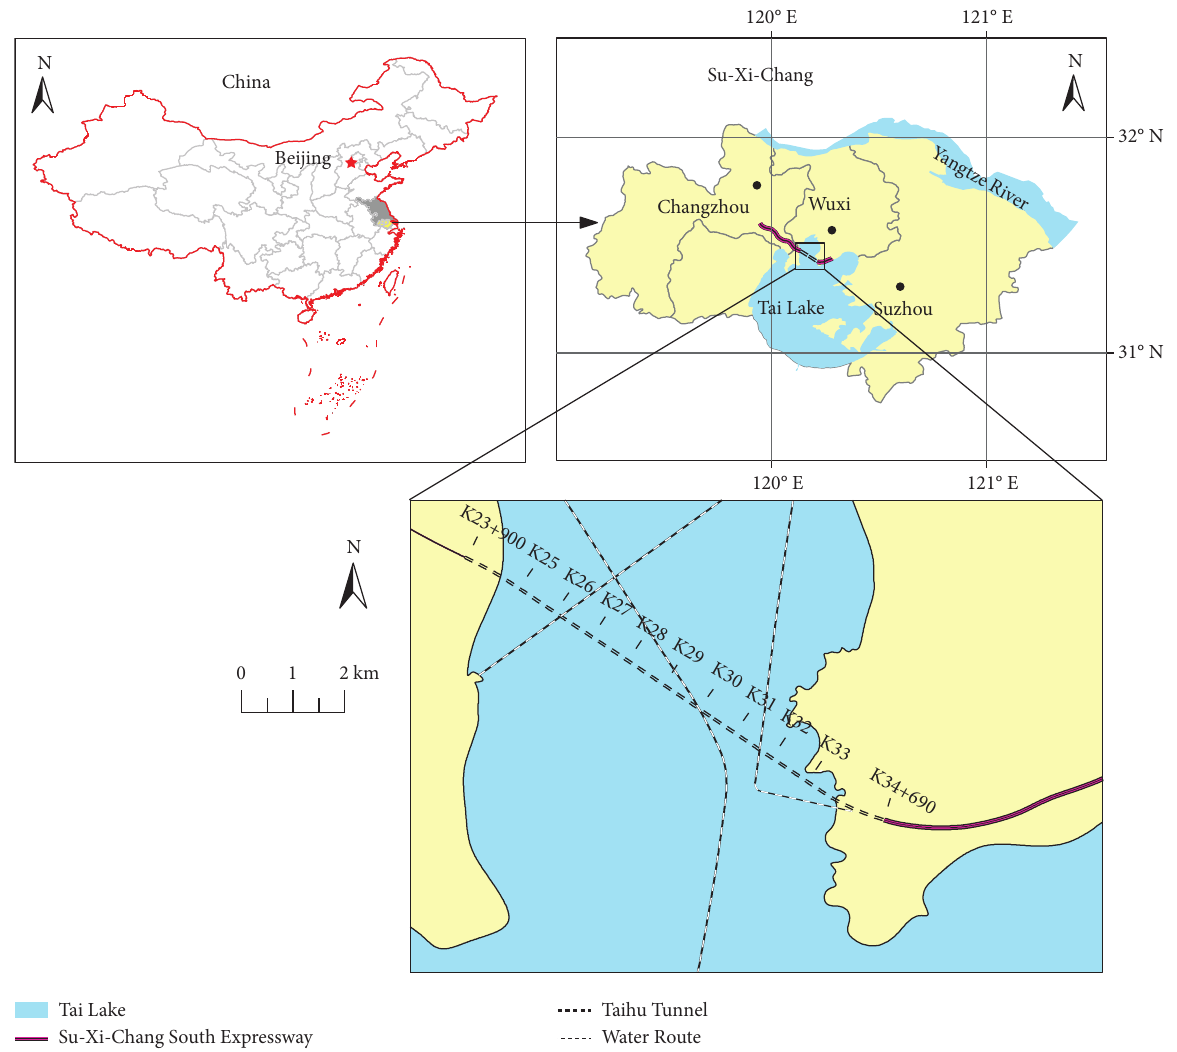
Figure 1: Location of the Taihu